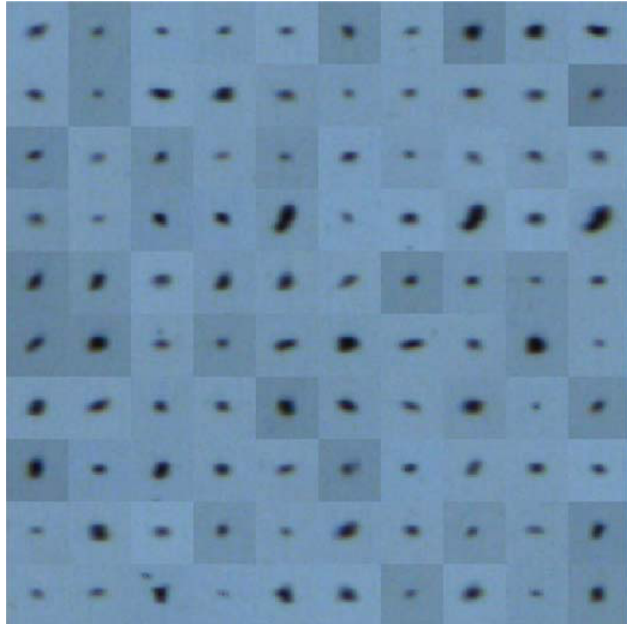
Fig. 9. Debris image